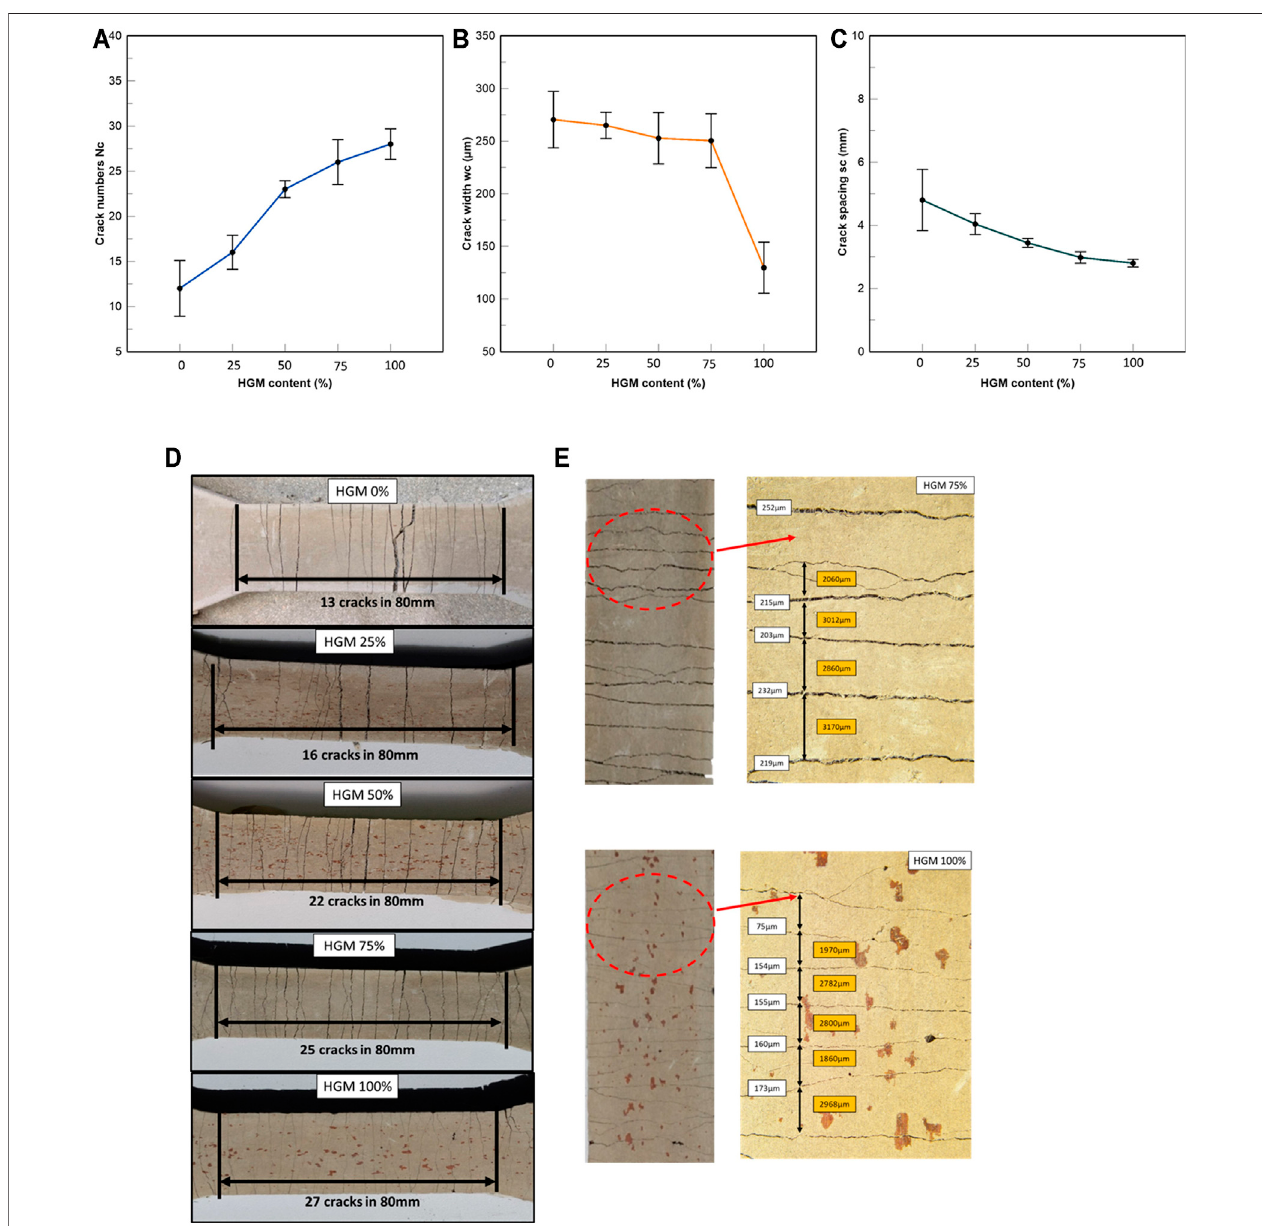
FIGURE 7 | (A) Crack numbers. (B) Crack width. (C) Crack spacing. (D) Crack patterns. (E) Microscopic observation of the